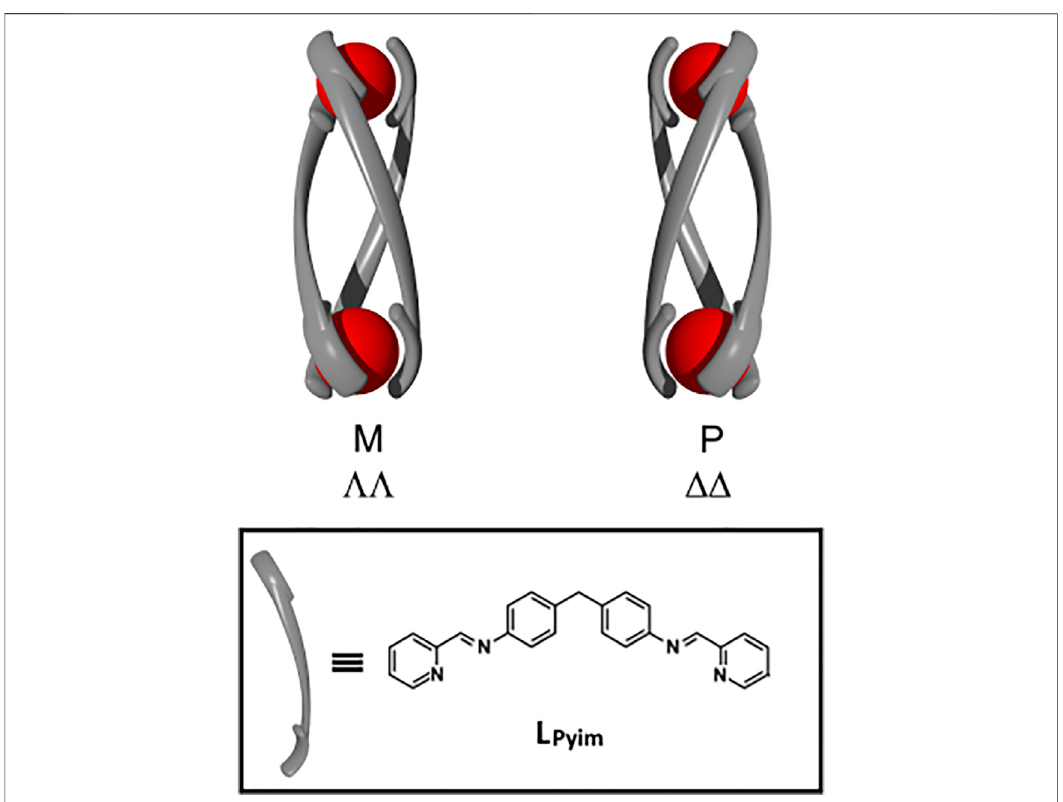
FIGURE 1 | Cartoon representations of the minus (M, ΛΛ ), plus (P, ΔΔ ) helicate isomers of a generic triple-stranded helicate and the chemical structure of the (1E,1 ′ E)-N,N ′ -[methylenebis(4,1-phenylene)]bis[1-(pyridin-2-yl)methanimine] ligand ( L Pyim ) developed by Hannon and co-workers (Hannon et al., 1997).